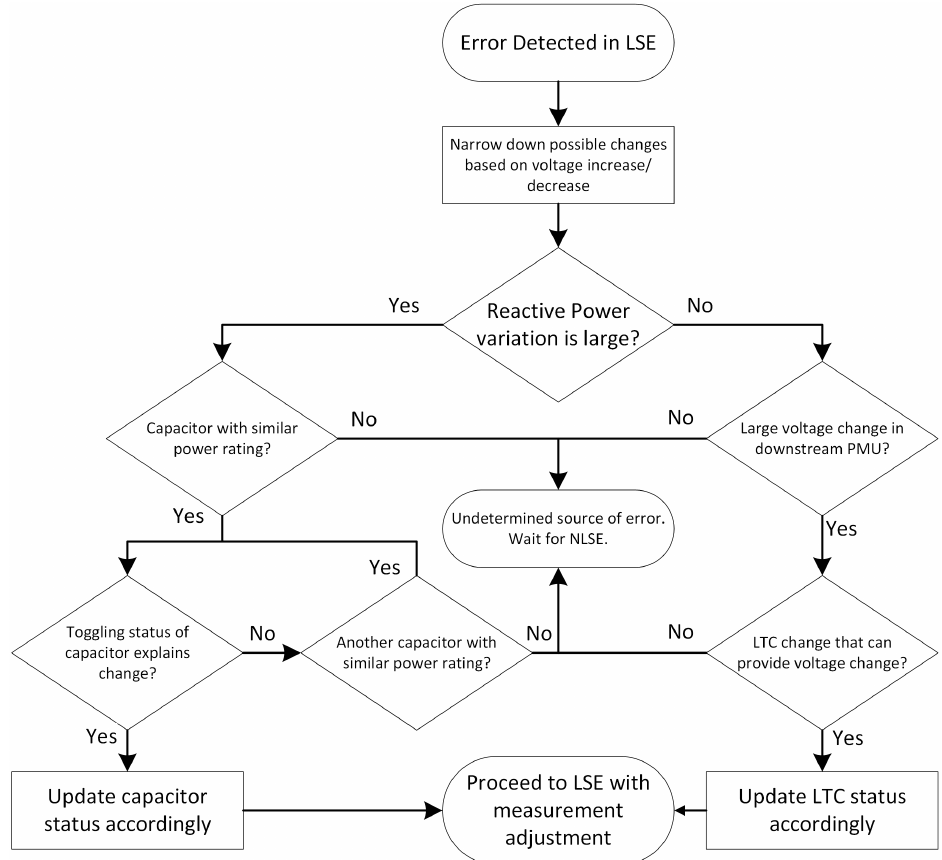
Figure 3. Flowchart for parameter error